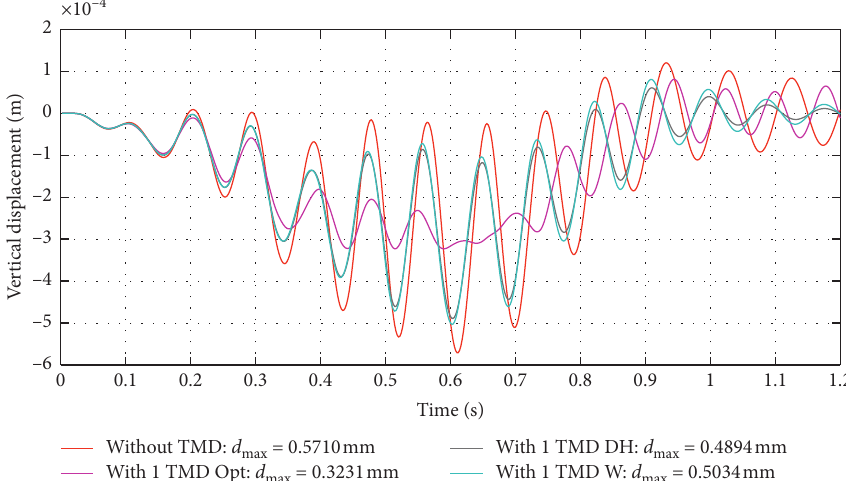
Figure 11: Vertical displacement at the bridge central node (node 18), as the vehicle moves along the bridge, for dynamic cases: without TMD (red curve), with 1 TMD optimized by the proposed method (magenta curve), with 1 TMD designed by Den Hartog’s method (gray curve), and with 1 TMD designed by Warburton’s method (cyan